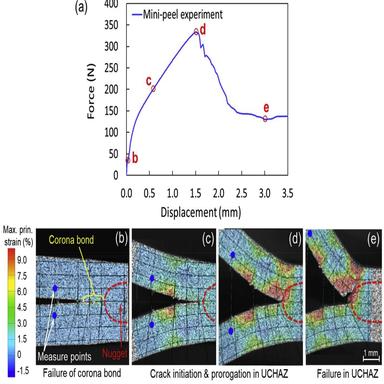
Mini-peel test results of the 6.5 kA joint. (a) Force-displacement curve; (b)-(e) selected DIC images showing the strain distributions of points b-e in (a).